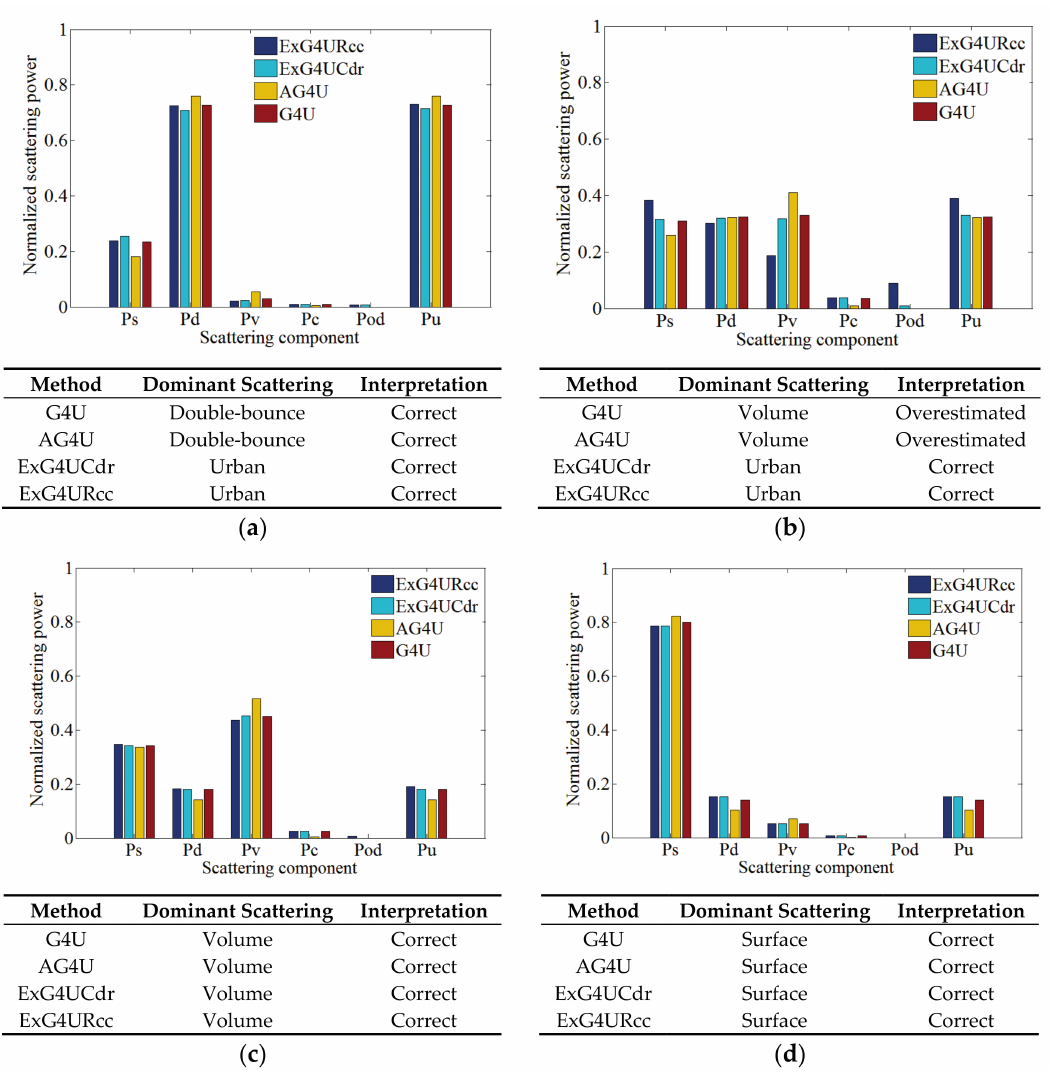
Figure 11. Bar chart of decomposition power contribution of different land covers: ( a ) orthogonal buildings; ( b ) oriented buildings; ( c ) woods; and ( d )